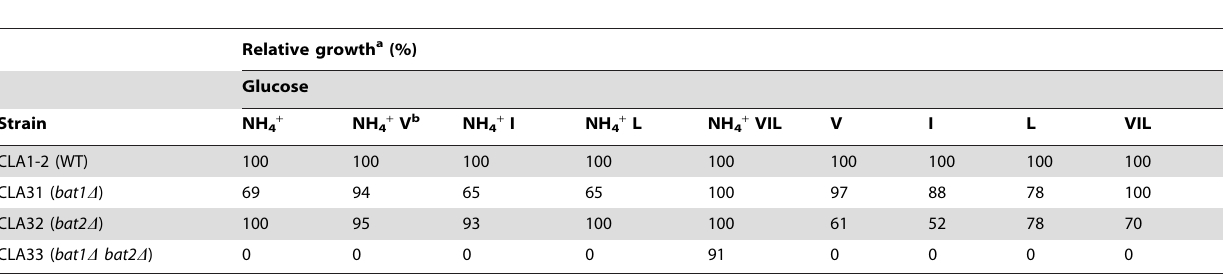
Table 2. In S. cerevisiae bat1 D mutant is impaired in VIL biosynthesis, while a bat2 D mutant is mainly impaired in VIL catabolism.